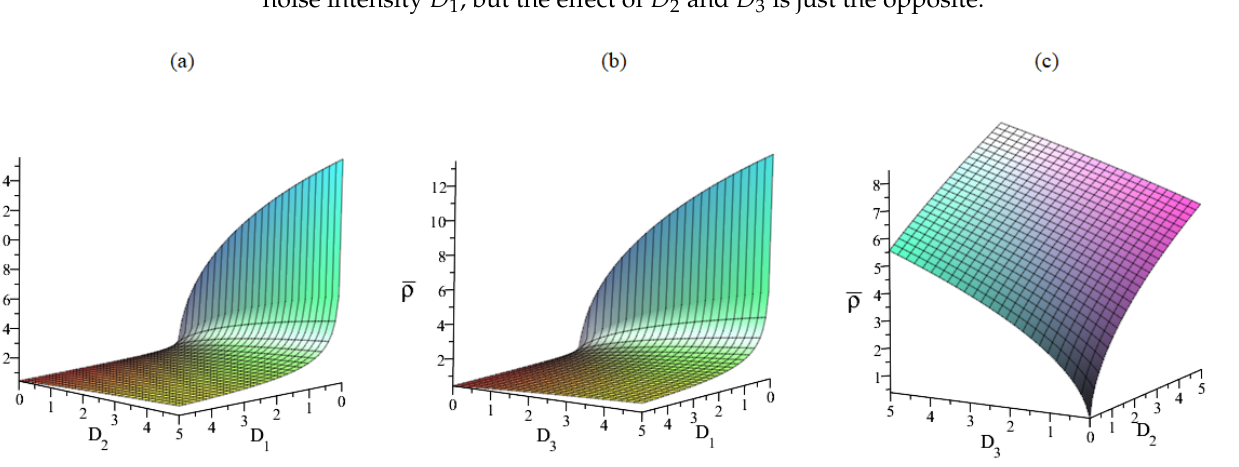
Figure 1. Maximum amplitude ¯ ρ for different noise intensities, where ( a ) D 3 = 0.15, ( b ) D 2 = 0.05, ( c ) D 1 =